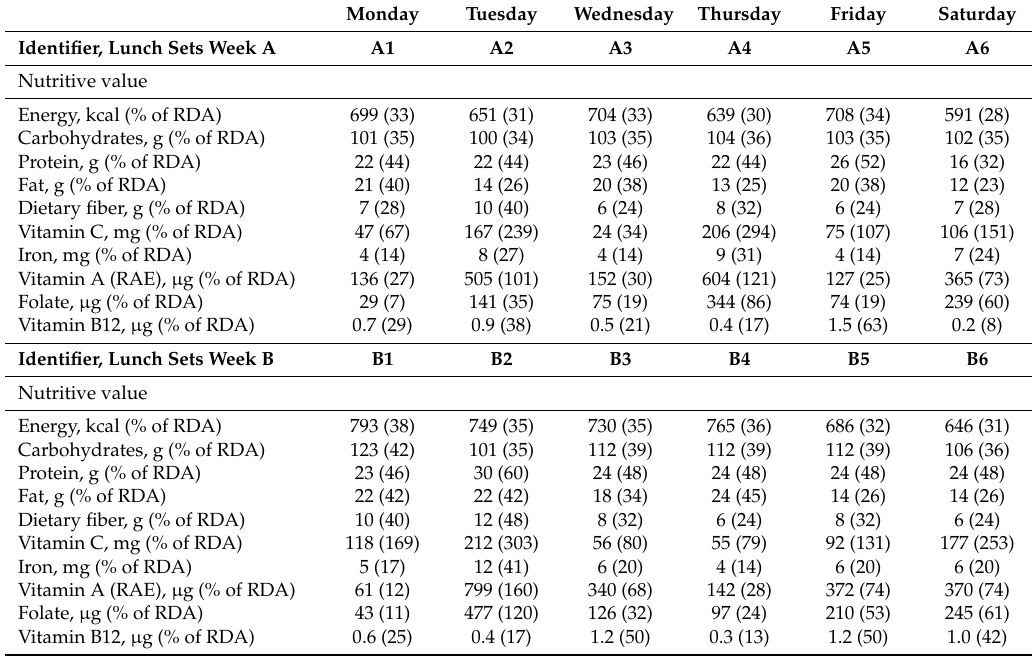
Table 5. Estimated nutritive value of low-price model lunch sets provided at a garment factory in Phnom Penh, Cambodia (menu Weeks A and B) 1,2